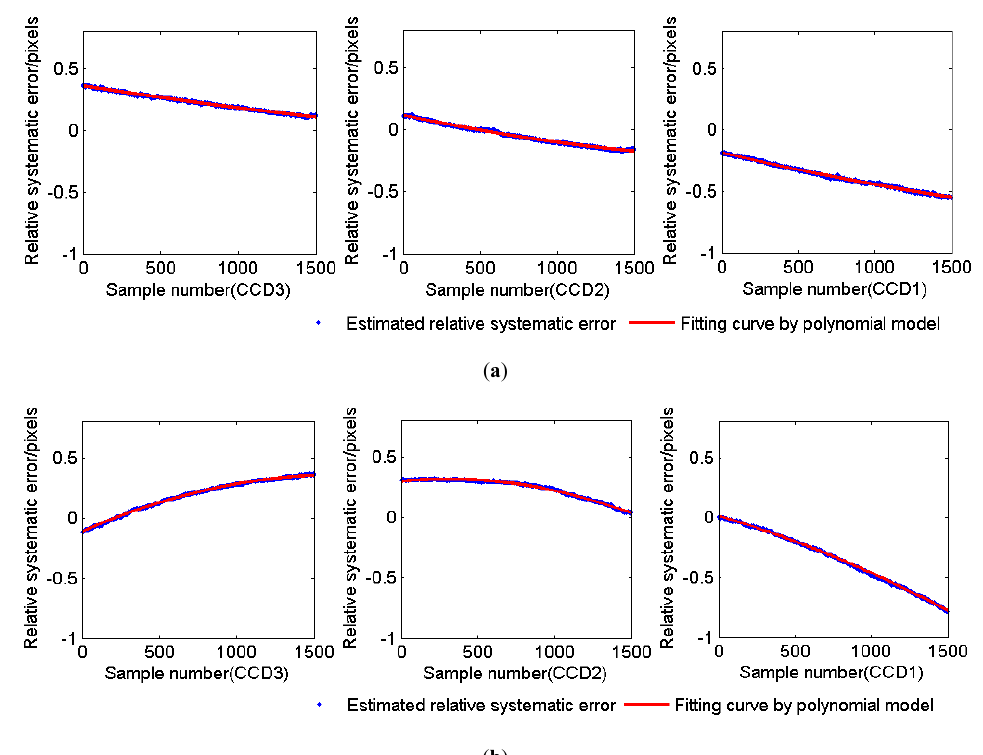
Figure 8. Relative systematic error between B1 and B2 in Scene C. ( a ) Across the track and ( b ) along the